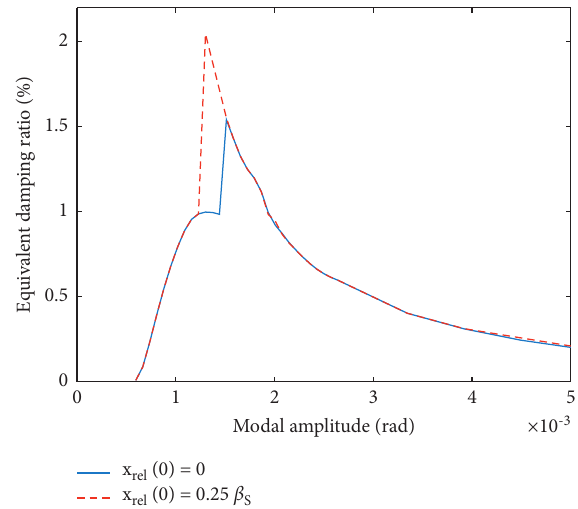
Figure 13: Influence of the initial values on the damping effect of the shock-friction the self-excitation and the damping provided by the damper.